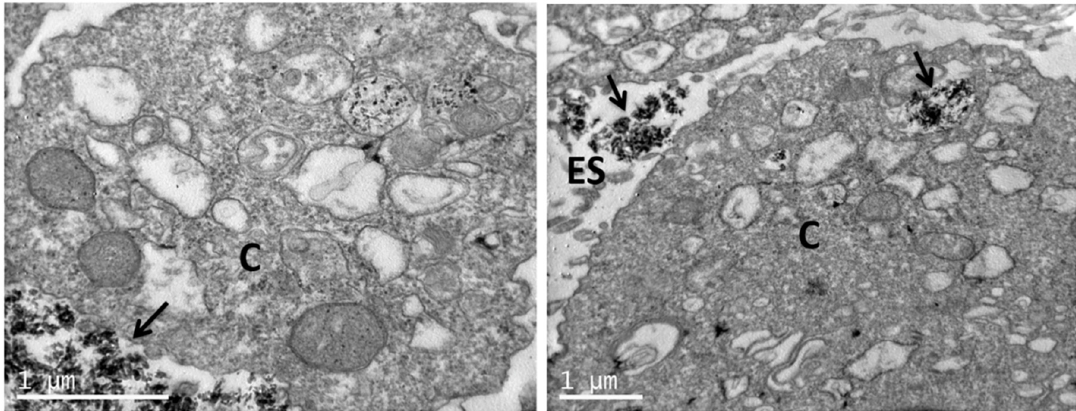
Figure 11. Representative TEM images showing nHA-3 uptaken by pre-osteoblastic cells. Nanoparticles of nHA-3 are shown localized in both the extracellular and the intracellular space in cyst-like structures. The scale bar represents 1 μ m. The letter C designates the cytoplasm, ES the extracellular space, and the arrows depict the nanoparticulated sample nHA-3.